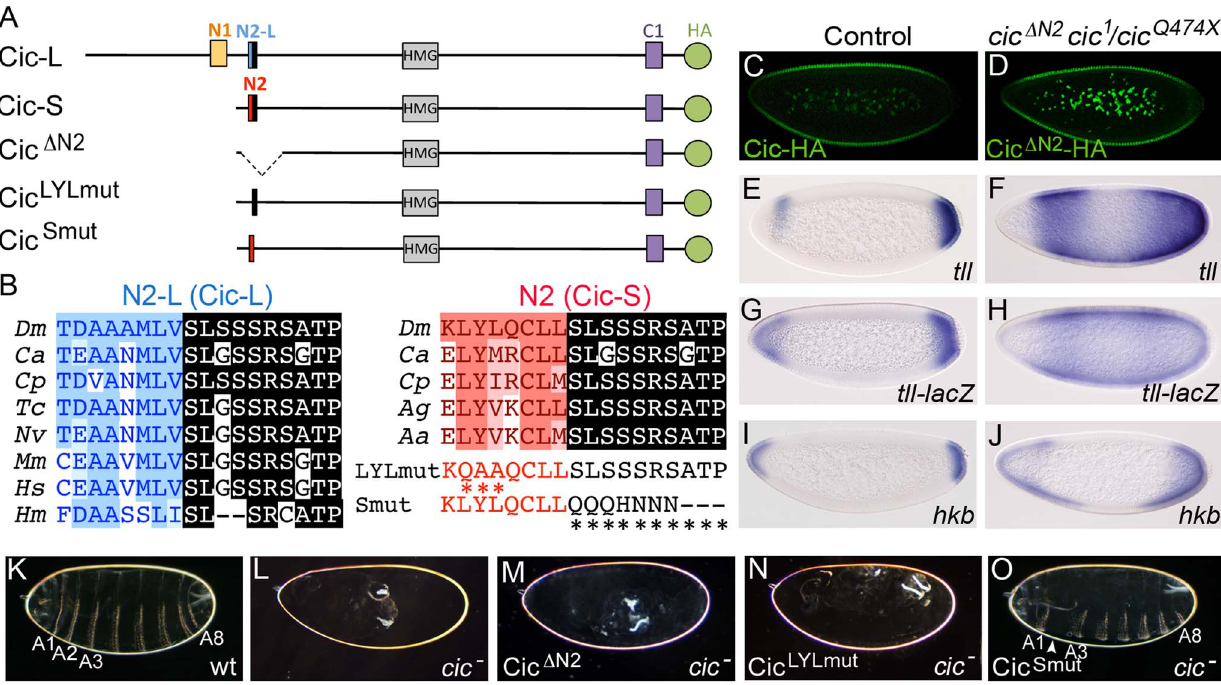
Fig. 3. The N2 motif is essential for Cic embryonic function. (A) Diagram of Drosophila Cic-L and Cic-S isoforms and three derivatives carrying mutations in the N2 motif. Cic-L and Cic-S are generated via use of alternative promoters and splicing sites, which produce different N-terminal domains. At the site of alternative splicing, Cic-L and Cic-S contain two different conserved motifs, N2-L and N2, which include different N-terminal sequences (shown in blue and red, respectively) and a common C-terminal peptide (highlighted in black). Other conserved domains (including the N1 and C1 domains of unknown function) are also indicated. The proteins are shown with an HA tag (green) to allow their visualization in transgenic embryos (see also below). (B) Alignment of Cic N2-L and N2 sequences from different species. Dm , Drosophila melanogaster ; Ca , Clogmia albipunctata ; Cp , Culex pipiens ; Tc , Tribolium castaneum ; Nv , Nasonia vitripennis ; Mm , Mus musculus ; Hs , Homo sapiens ; Hm , Hydra magnipapillata; Ag , Anopheles gambiae ; Aa , Aedes aegypti . Two different mutations of the N2 peptide (LYLmut and Smut) are also shown below the N2 alignment. (C and D) Expression of Cic and Cic D N2 proteins tagged with the HA epitope in embryos stained with anti-HA antibody; note that both proteins appear downregulated at the embryo poles. (E-M) mRNA expression patterns of tll , tll-lacZ and hkb in wt (E, G, I) and cic mutant ( cic 1 /cic Q474X ) embryos expressing Cic D N2 (F, H, J). Cuticle phenotypes of the same genetic backgrounds are shown in K and M, respectively; panel L shows a control cic 1 / cic Q474X mutant cuticle. (N and O) Cuticle phenotypes of cic 1 /cic Q474X mutant embryos expressing the Cic LYLmut (N) and Cic Smut (O) derivatives; only Cic Smut rescues the cic phenotype, except for mild segmental defects (arrowhead). A1-A8, abdominal segments 1–8.